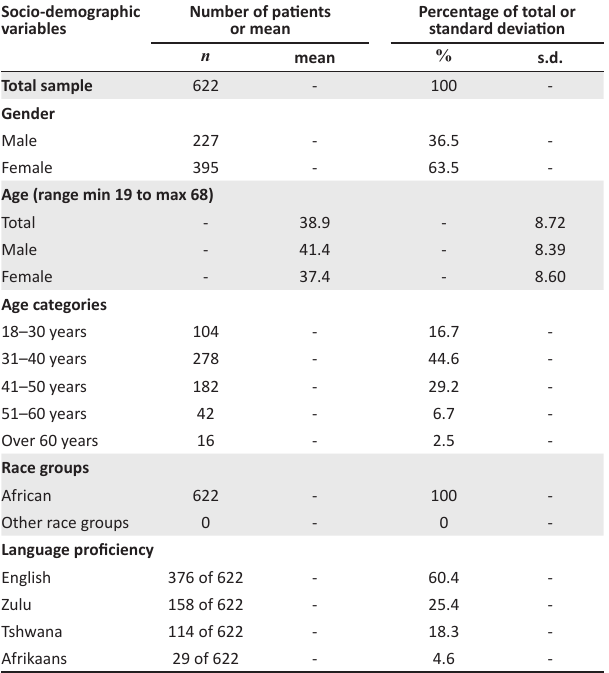
TABLE 1: The characteristics of study sample.